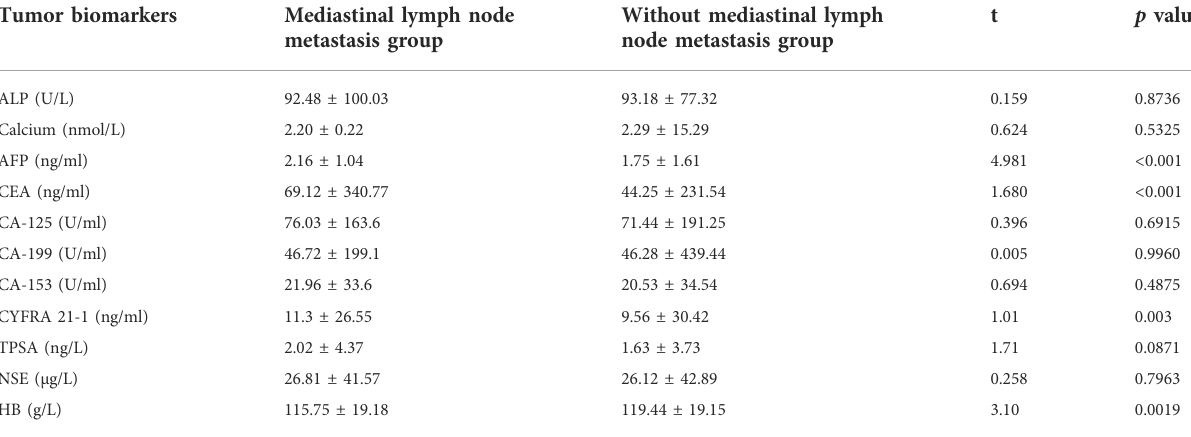
TABLE 2 Differences in tumor biomarkers between lung cancer patients with and without mediastinal lymph node metastasis.